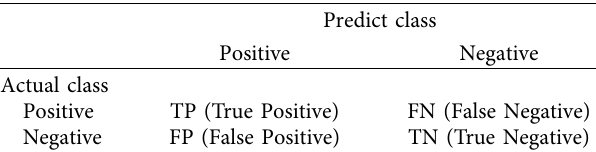
Table 3: Description of TP, FP, TN, and